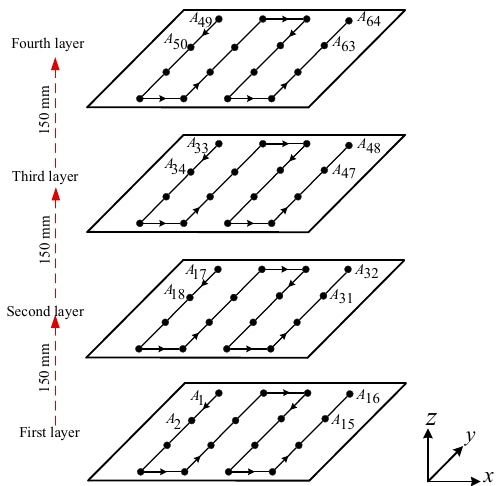
Figure 5. Experimental platform.